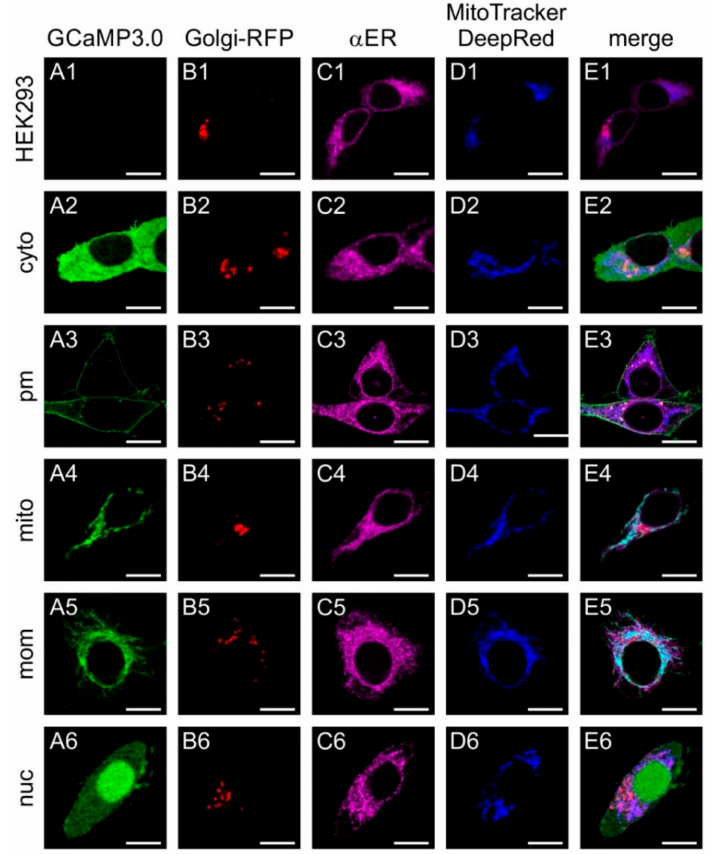
Figure 1. Sub-cellular distribution of transiently expressed GCaMP3.0 variants . Human embry- onic kidney cells (HEK293) were either non-transfected with a GCaMP3.0 encoding construct ( A1 – E1 ) or with GCaMP3.0cyto ( A2 – E2 ), GCaMP3.0pm ( A3 – E3 ), GCaMP3.0mito ( A4 – E4 ), GCaMP3.0mom ( A5 – E5 ), or GCaMP3.0nuc ( A6 – E6 ). Expression of GCaMP3.0 variants was detected by their